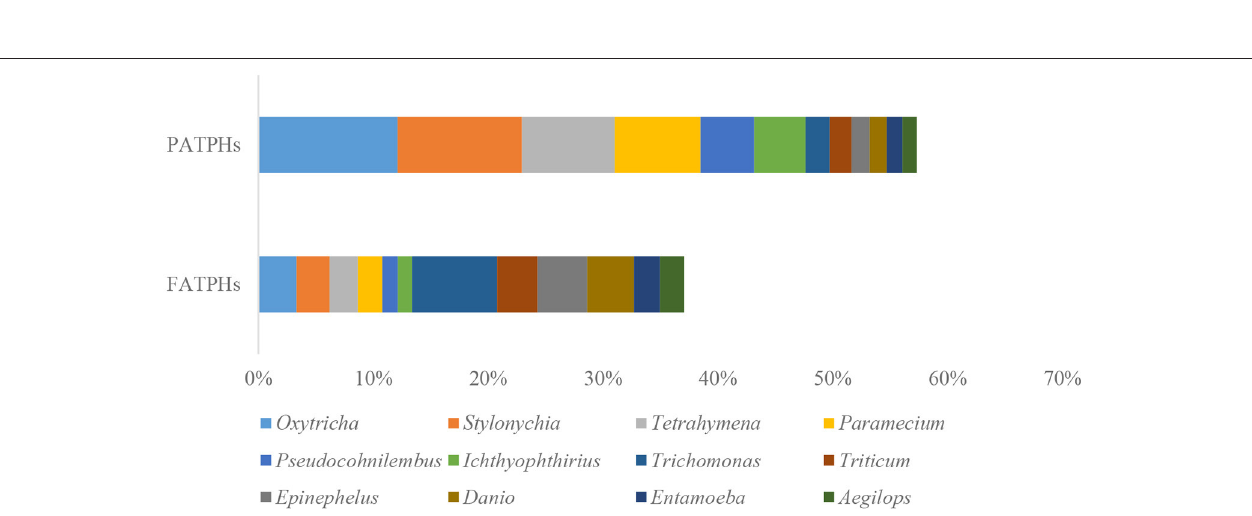
FIGURE 7 | Relative abundances of eukaryota genera ranked by one and zero orders of magnitude in PATPHs shown together with relative abundances of the corresponding genera in FATPHs.